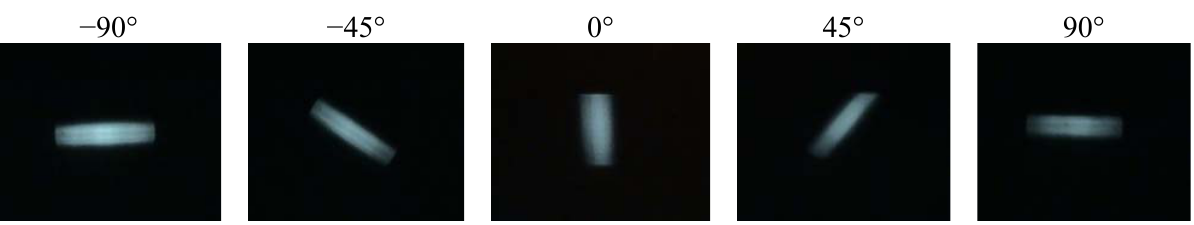
Figure 12. Shape of the laser beam at different scanning